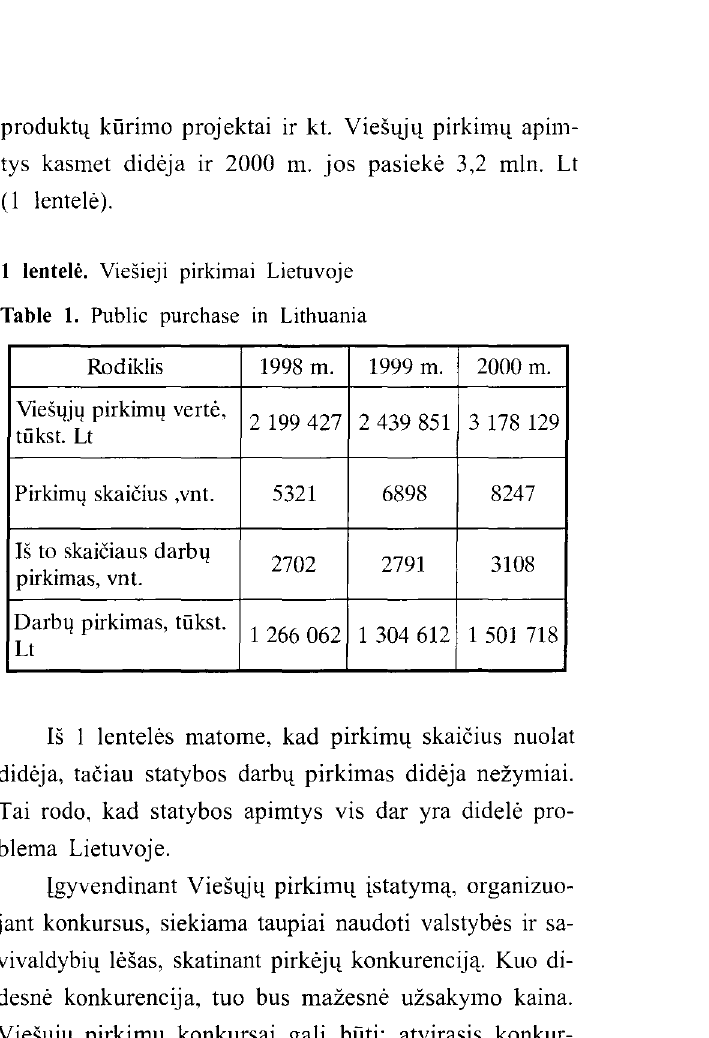
Table 1. Public purchase in Lithuania Rodiklis 1998111. 1999